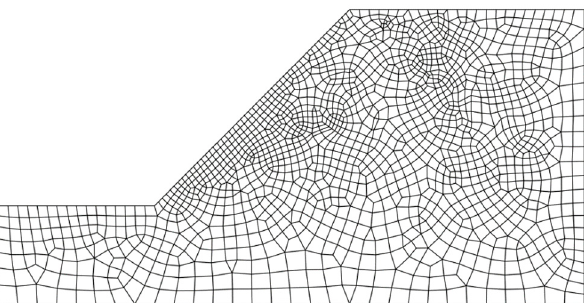
Figure 16. The irregular mesh for the soil-rock mixture slope.